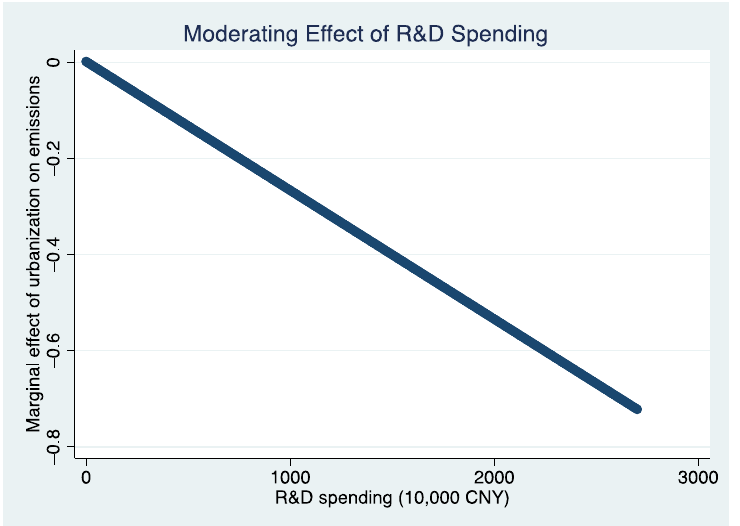
Figure 5. Moderating effect of R&D spending.